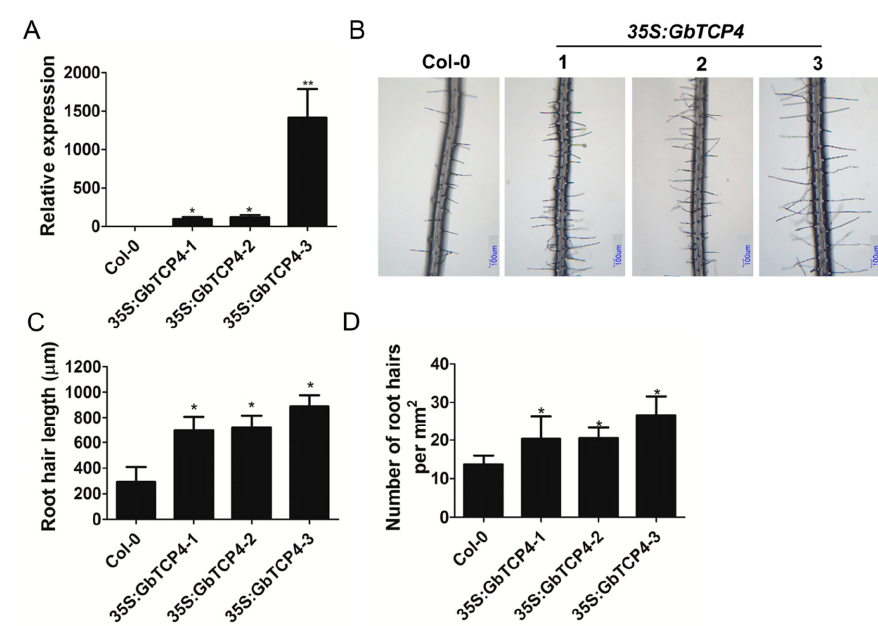
Figure 4. Constitutive overexpression of GbTCP4 in Arabidopsis increases root hair length. ( A ) Transcriptional levels of the GbTCP4 gene in three 35S:GbTCP4 transgenic Arabidopsis lines.